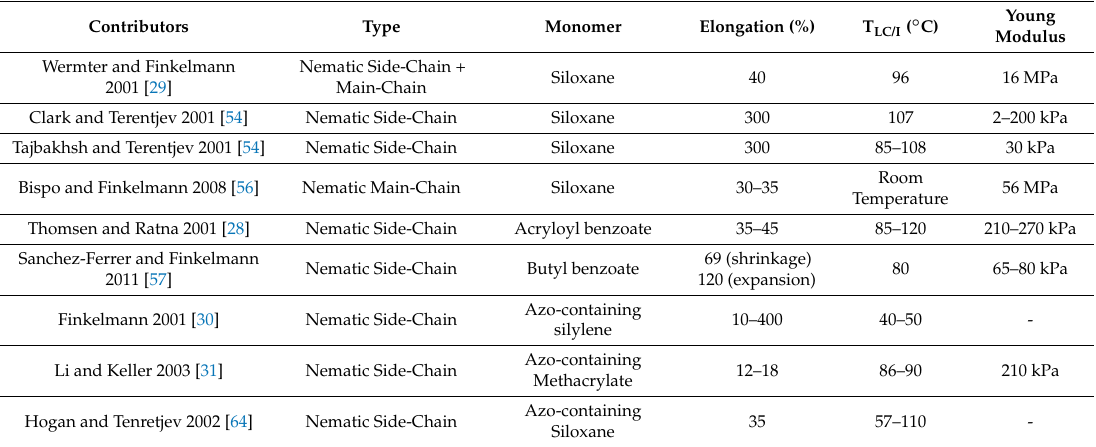
Table 2. Overview of the main characteristics of thermo- and photo-responsive LCE films reported in this